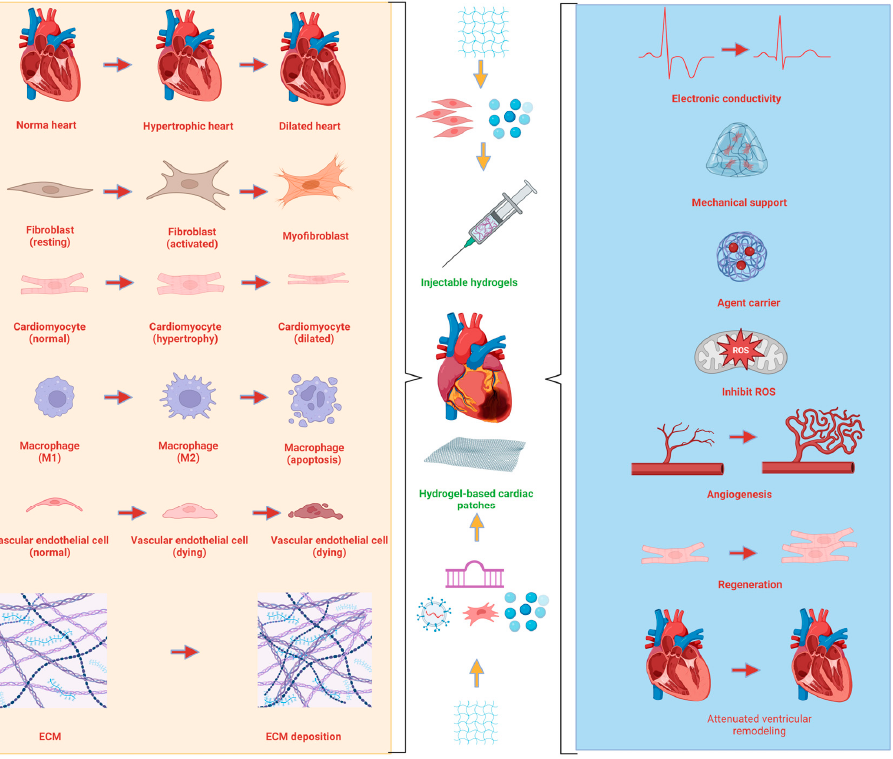
Figure 3. The pathophysiological changes of myocardial infarction and the applications of hydrogels in cardiac repair and regeneration for MI. Created with BioRender.com.